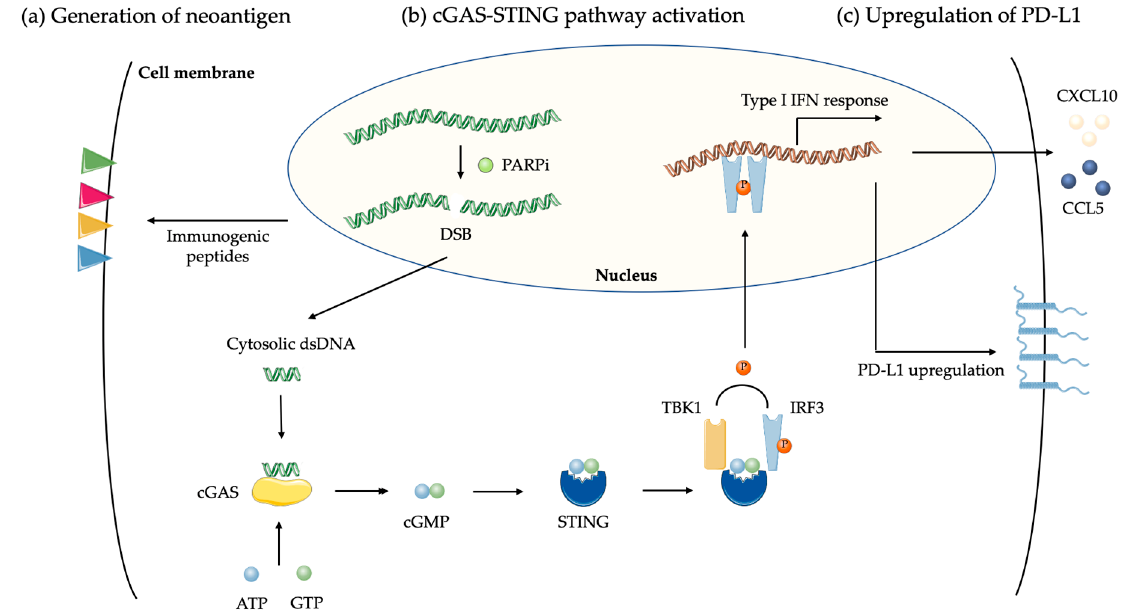
Figure 2. Biological effect of PARPi on cancer cells. ( a ) PARPi delays DNA repair that generates double-strand breaks (DSB) and catastrophic unrepaired DNA damages in tumor cells, increasing neoantigens load and tumor mutation burden; ( b ) DSB induced by PARPi in tumor cells produce double-strand DNA (dsDNA) fragments that, through cyclic GMP-AMP synthase (cGAS) binding, lead to stimulator or interferon genes (STING) activation and the generation of a type I interferon (IFN) response. This upregulates chemokines CCL5 and CXCL10 leading to T cell recruitment; ( c ) Upregulation of PD-L1 via STING pathway lead to T cell exhaustion.